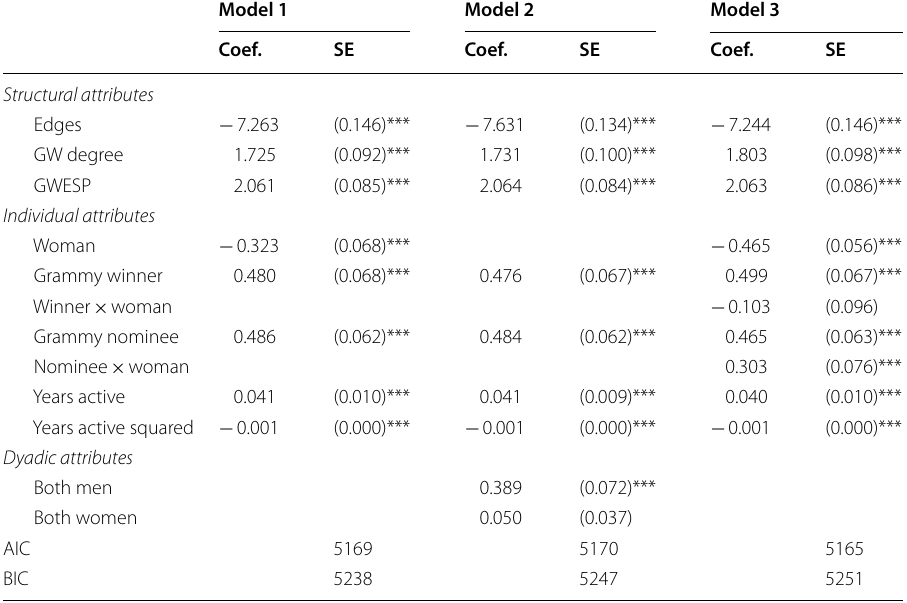
Table 3 ERGM results for 2012–2020 R&B/hip hop collaboration